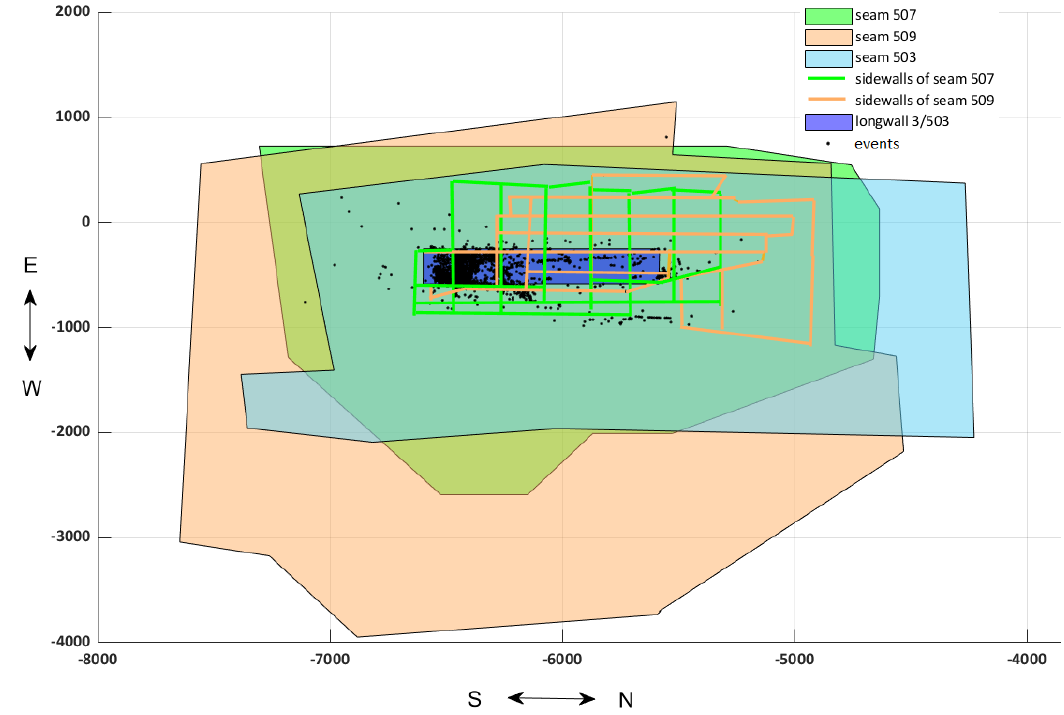
Figure 10. Flat projection of the boundaries of seams 503, 507, and 509; the range of exploited face 3 / 503; and the location of the shafts delimiting the exploited faces in seams 507 and 509. The black points show the location of the cloud of phenomena following the collapse.